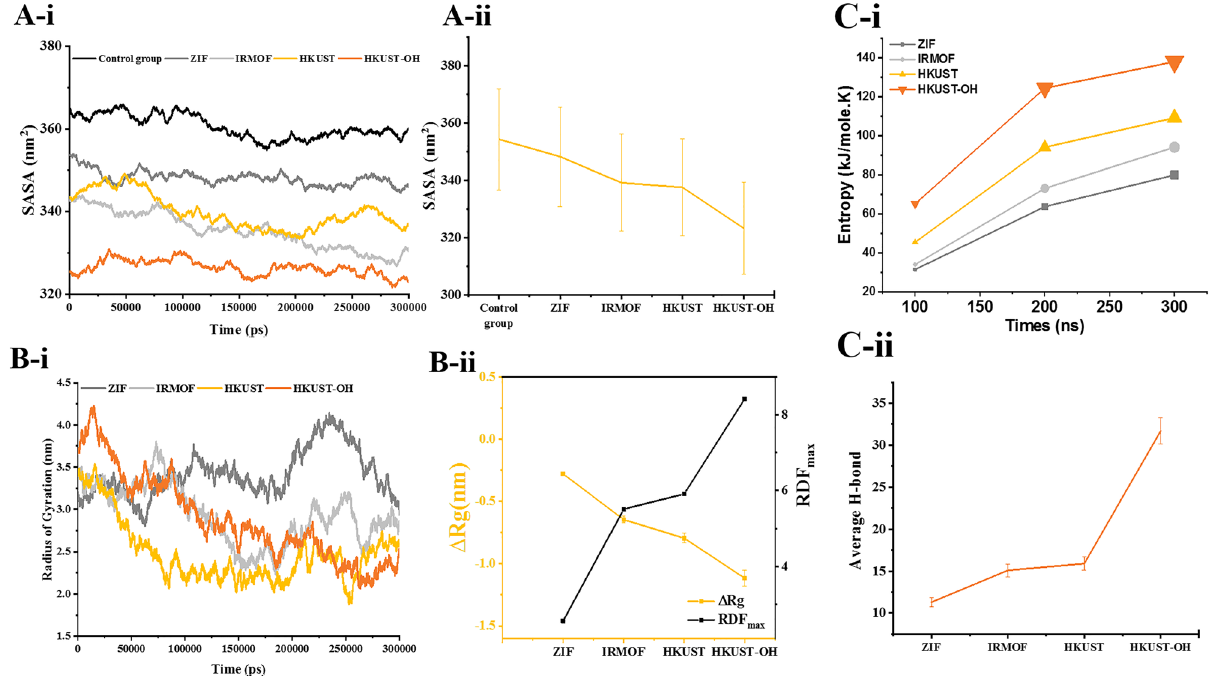
Figure 6. ( A-i , ii ) SASA of deformed M pro with MOFs together with the control group for comparison purposes in the course of simulation and average, respectively. ( B-i ) Variation of Rg over the simulation time of MOFs’ interaction with M pro . ( B-ii ) The difference between final and initial Rg (ΔRg) of the M pro in the interaction with MOFs to get more insight on the compactness of each case together with maximum radial distribution function (RDF). ( C-i ) Entropy of M pro -MOF interaction over the simulation time. ( C-ii ) Average numbers of H-bonds between MOFs and M pro